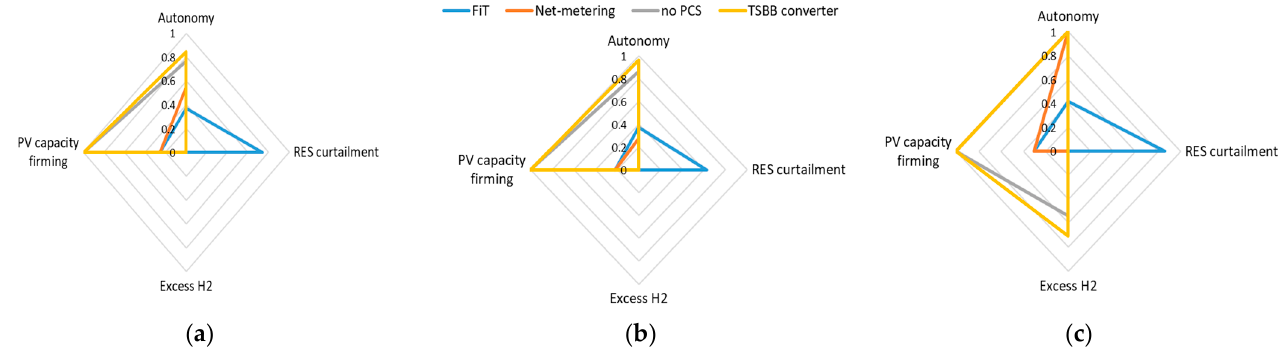
Figure 10. Overall comparisons for different metrics pertaining: ( a ) 3 kW; ( b ) 5 kW; and ( c ) 7 kW PV systems.